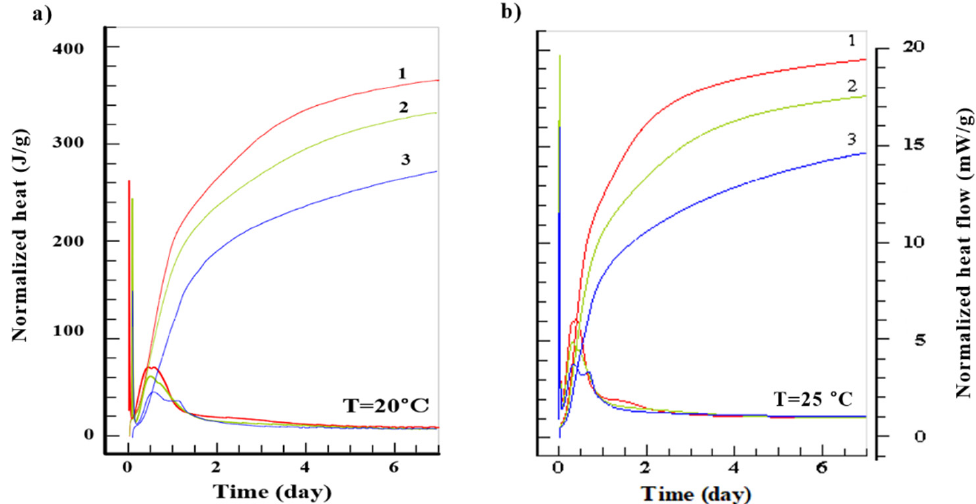
Figure 1. Amount of generated heat (J/g) and heat flow (mW/g) of studied cements: 1. CEM I 52.5 R, 2. CEM I 42.5 R, 3. CEM III 42.5 N for curing temperatures 20 °C ( a ) 25 °C ( b ).